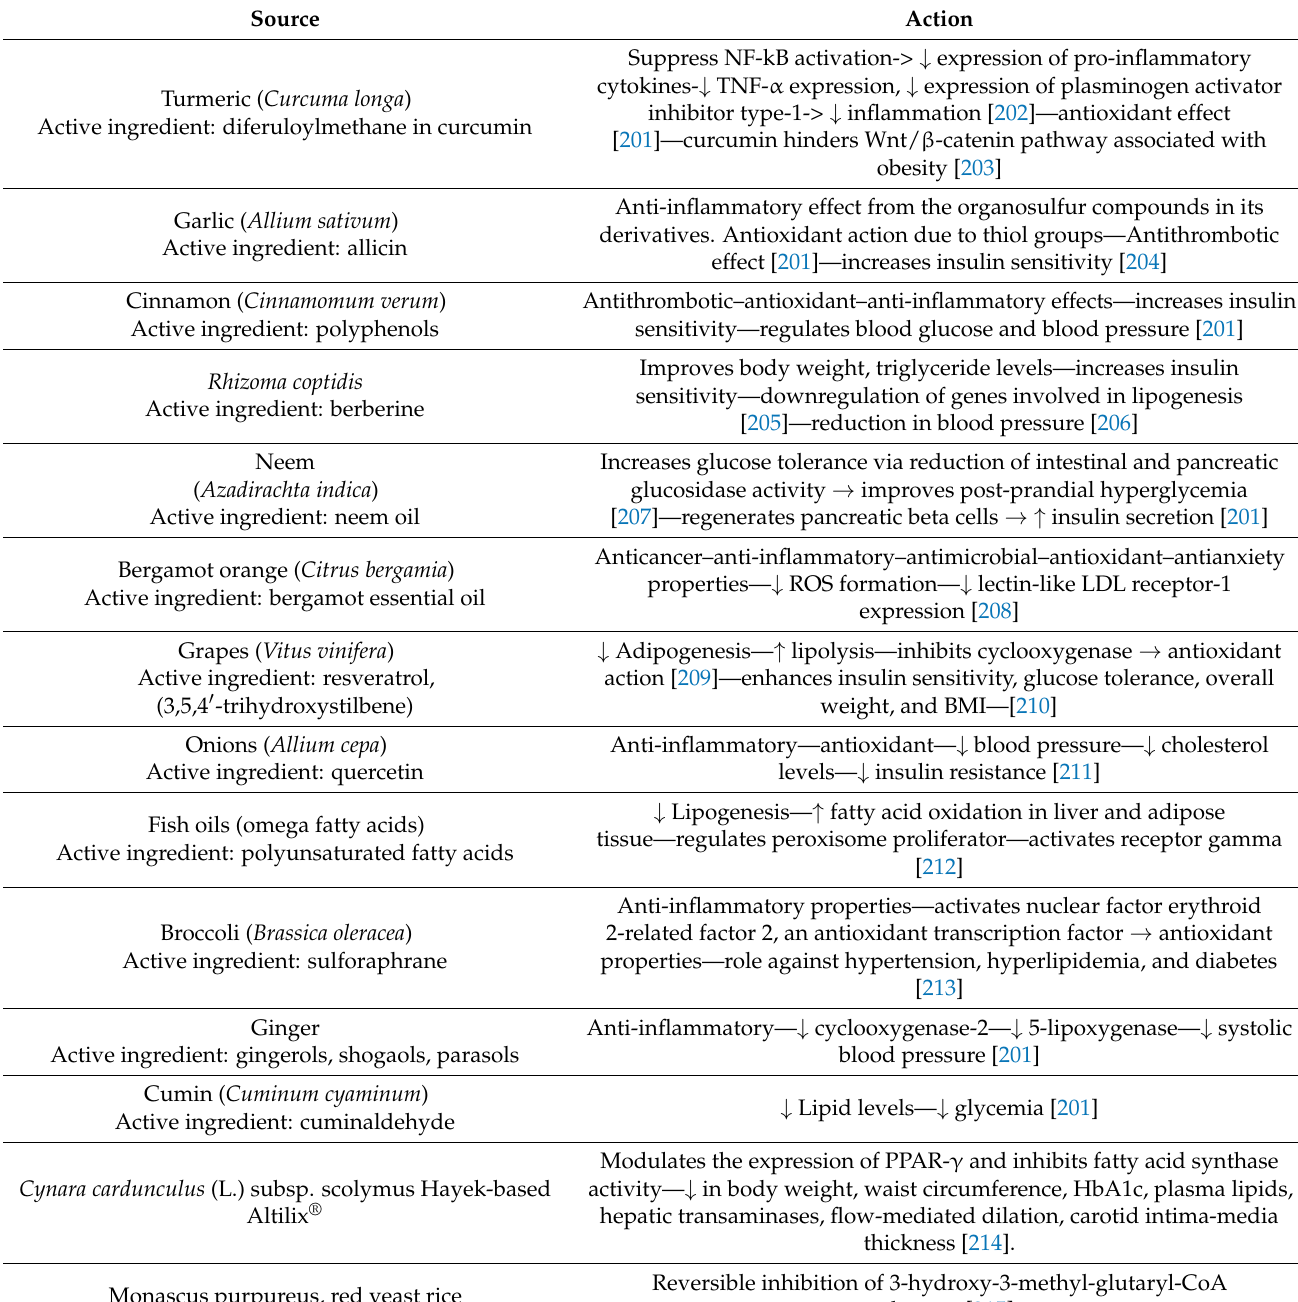
Table 5. Role of nutraceuticals in MetS. ↑ signifies increase. ↓ signifies